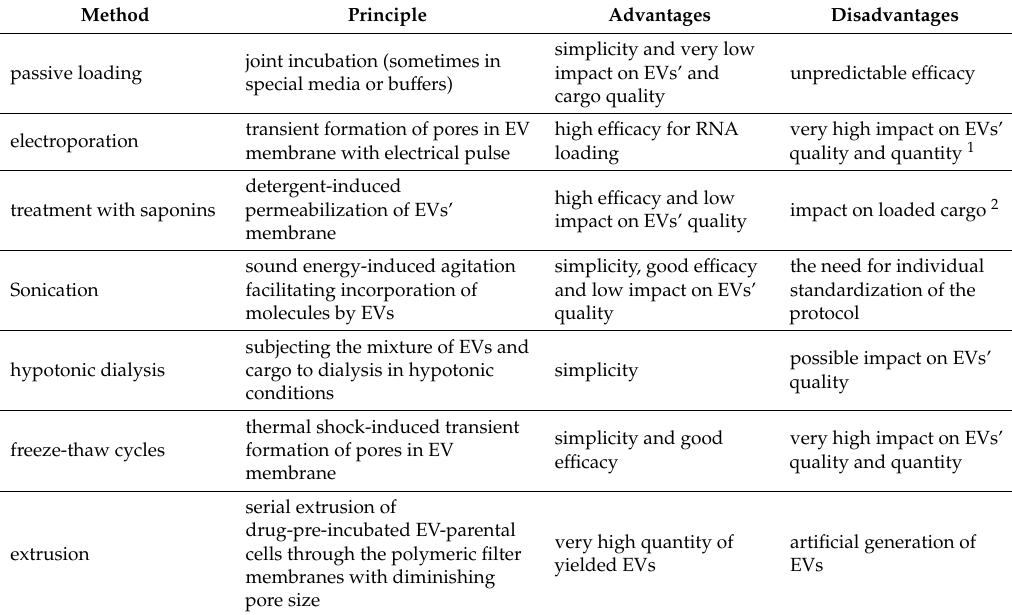
Table 1. Comparison between the methods used for loading Extracellular vesicles (EVs) with selected